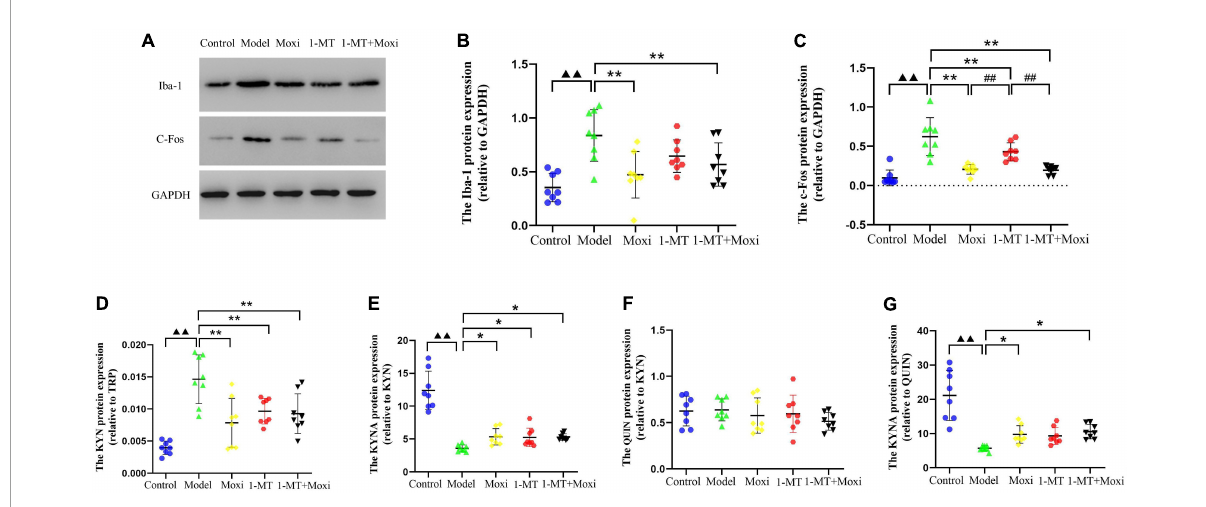
FIGURE8 Effects of moxibustion, 1-MT, or a combination of both on improving hippocampal neuronal activity and microglia activation markers in each group of rats. (A) Western blot bands of Iba-1 and c-fos protein expression, (B) Iba-1 protein expression, (C) c-fos protein expression, (D) KYN/TRP ratio, (E) KYNA/KYN ratio, (F) QUIN/KYN ratio, and (G) KYNA/QUIN ratio in the hippocampus of rats in each group. n = 8 per group. (cid:78)(cid:78) P < 0.01 vs. control group; * P < 0.05, ** P < 0.01 vs. model group; ## P < 0.01 vs. 1-MT group.